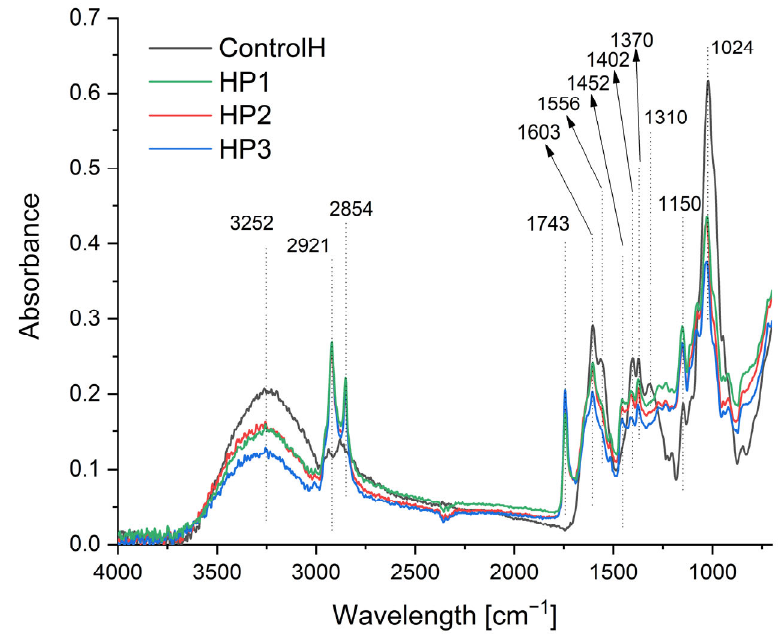
Figure 3. FTIR spectra of the obtained films.